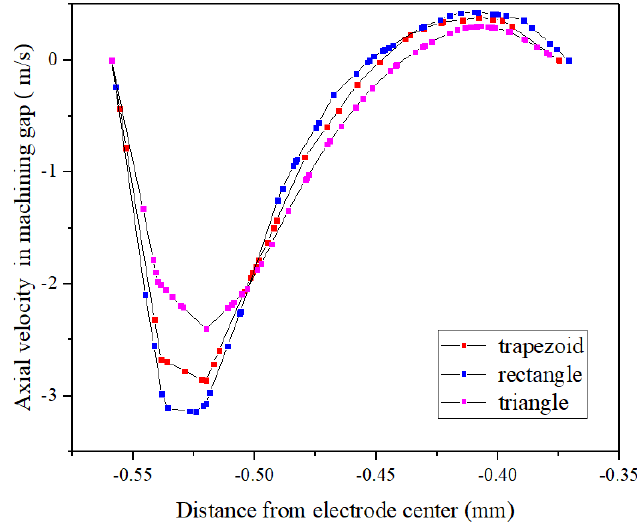
Figure 7. Axial velocity distributions in lateral machining gap with different helical electrodes.